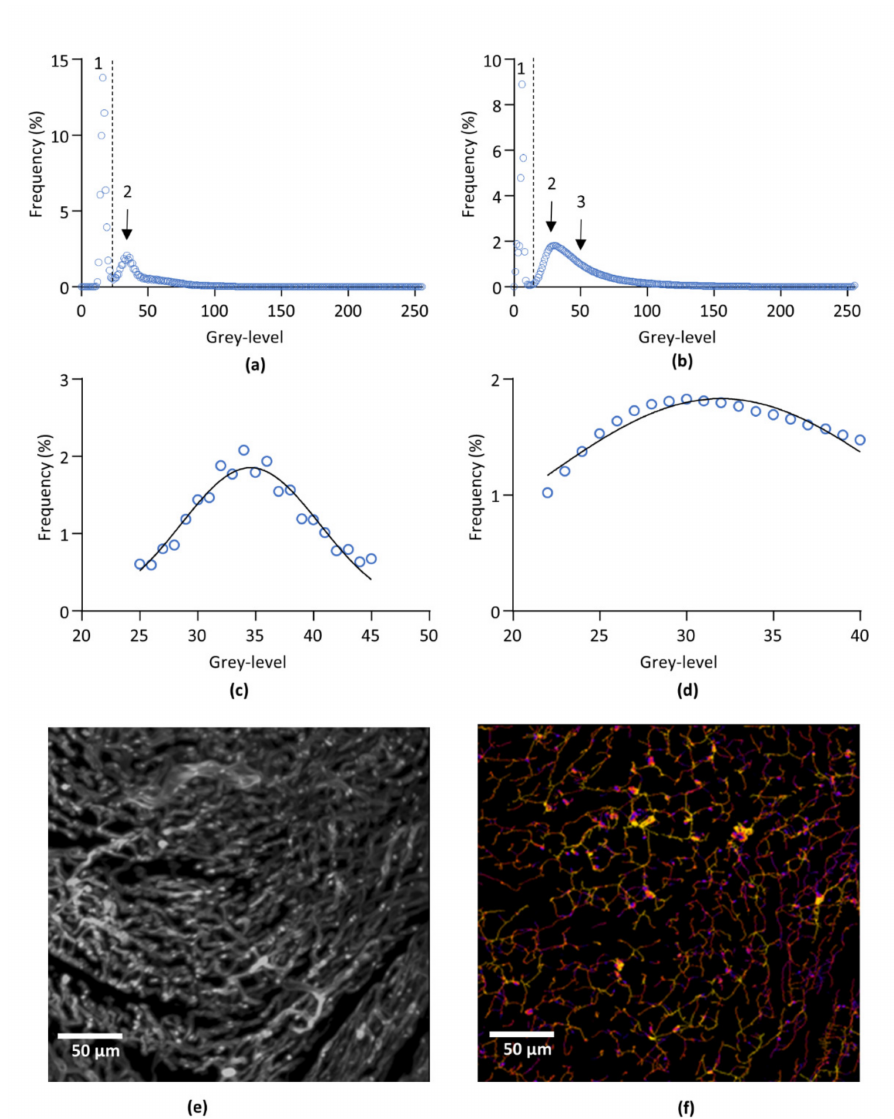
Figure 1. Image processing. ( a , b ) Representative frequency distribution of pixel population of non-labelled (negative control) ( a ) and lectin-labelled ( b ) left ventricle after 3D imaging by light sheet microscopy. 1: background. 2: non-labelled cardiac tissue. 3: lectin-labelled capillary network. ( c ), Gaussian fit of the subset of pixels corresponding to the cardiac tissue from curve ( a ). ( d ), Gaussian fit of the subset of pixels corresponding to the cardiac tissue from curve ( b ). ( e ), Representative segmented image of left ventricle capillary network. The image was obtained by overlaying the original capillaries image and the binarized image of the capillaries obtain after segmentation. ( f ), Skeletonization and image mapping of the capillary network of ( e ). Average radii of each segment are encoded in false colors from blue to red. The image was obtained by overlaying the skeleton and the distance map images of the capillary